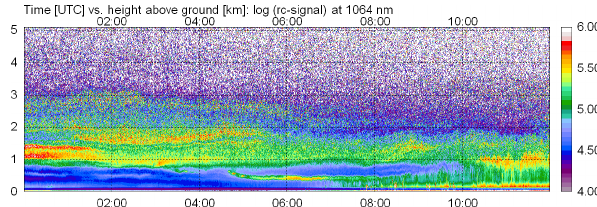
Figure 17. Time–height cross section of the range-corrected signal (in arbitrary units, logarithmic scale) of the CHX-1, similar to Fig. 9 but for 14 August 2015 (Case C).